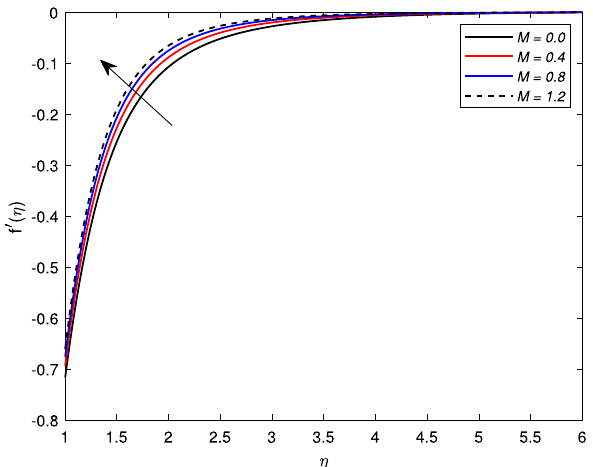
Figure 2. Impact of magnetic parameter M on f ′ (η) when A